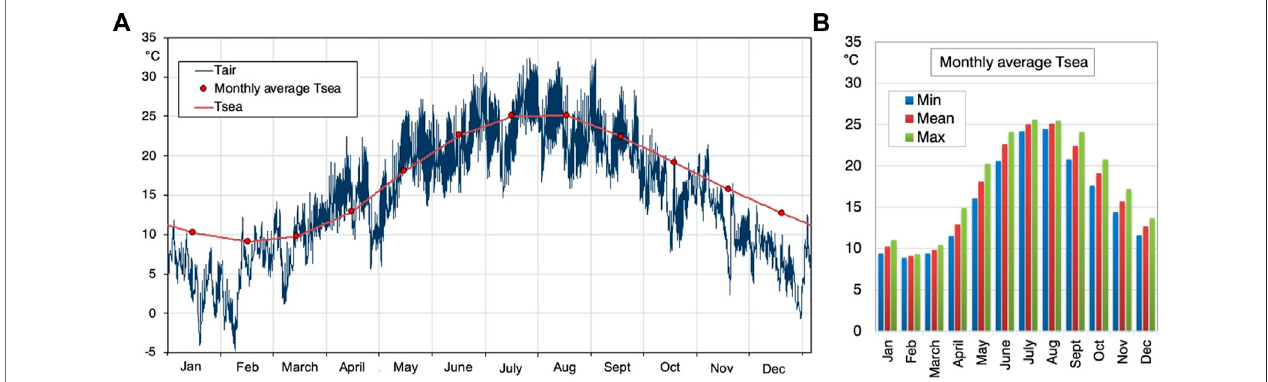
FIGURE3| Hourlytrendoftheoutdoorairtemperature(Tair)andmonthlyaverageseawatertemperatures(Tsea) (A) .Monthlyaveragesoftheminimum,mean,and maximum daily seawater temperatures (B) .The linear interpolating trend of Tsea is also reported in panel (A) .